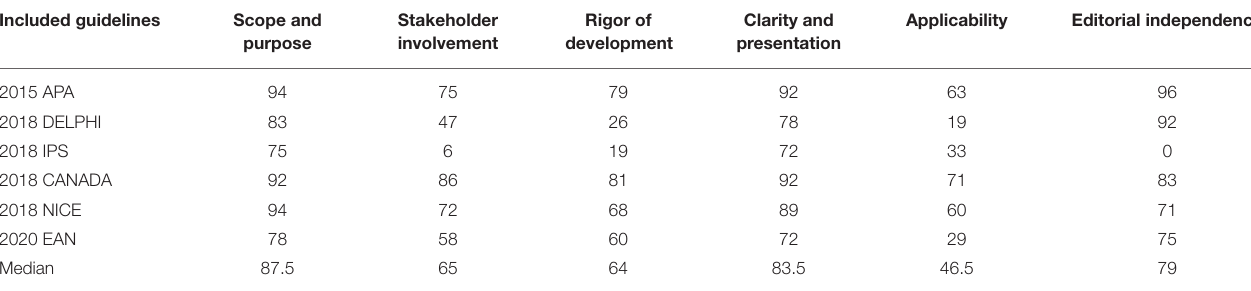
TABLE 2 | Quality appraisal of dementia guidelines with the AGREE II instrument.